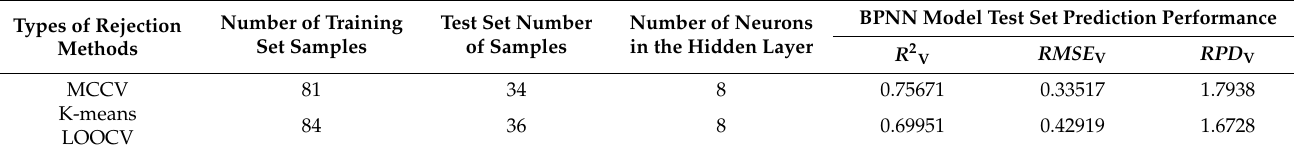
Table 4. Comparison results of different abnormal sample rejection methods.